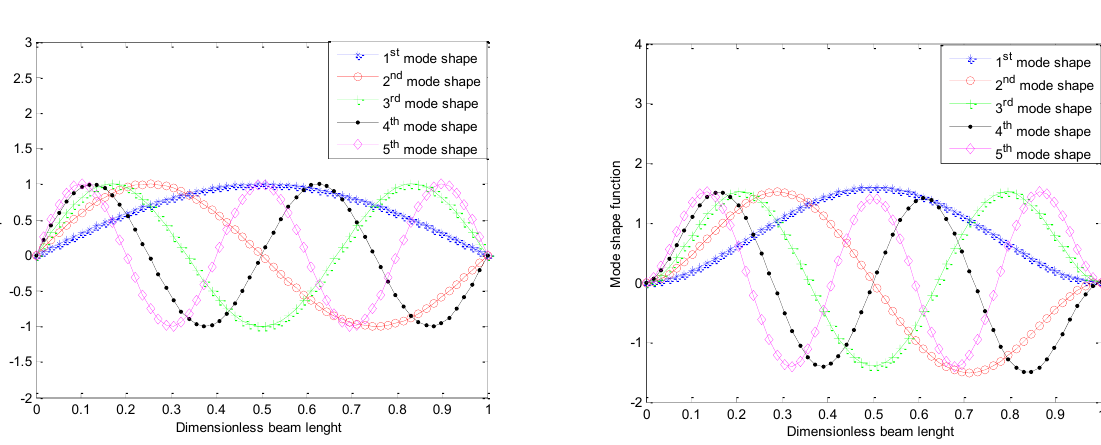
Figure 4: The first five normalized mode shaped of the beam under simple-simple supports